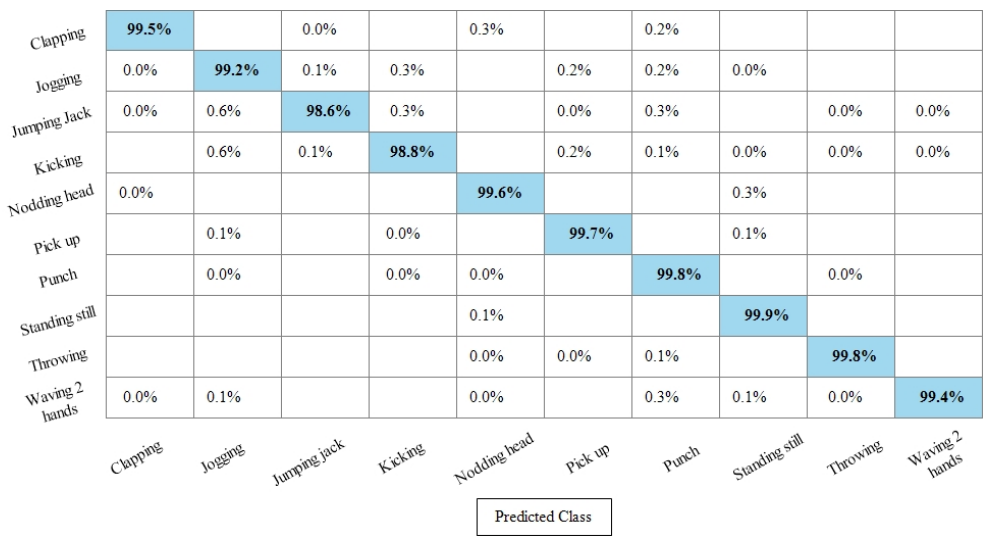
Table 10. Achieved results on IXMAS dataset after best feature selection using KcWKNN. The bold The results of the KcWKNN-based best features selection on the IXMAS dataset are represents the best obtained values. provided in Table 10. In this table, it is noted that the Fine KNN attained best accuracy